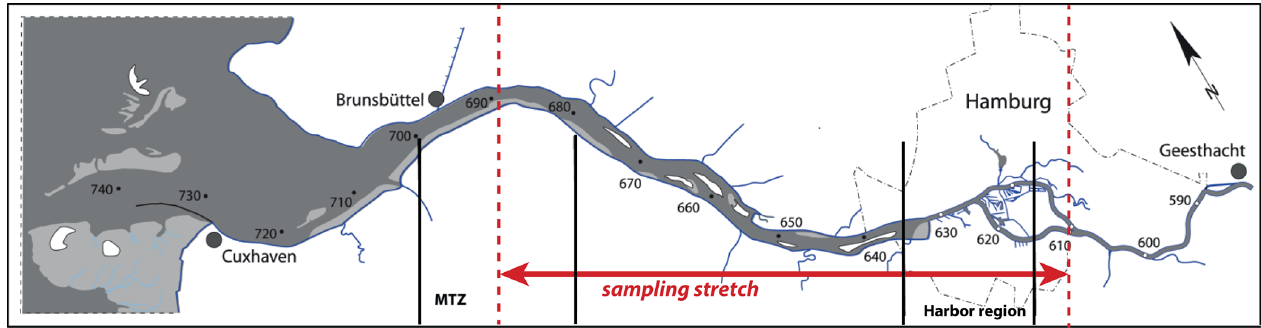
Figure 1. The Elbe Estuary: the stretch of the sampling transect is indicated in red; vertical black lines show the location of the Hamburg Harbor area (stream kilometer 615–635) and of the estuarine maximum turbidity zone (stream kilometer